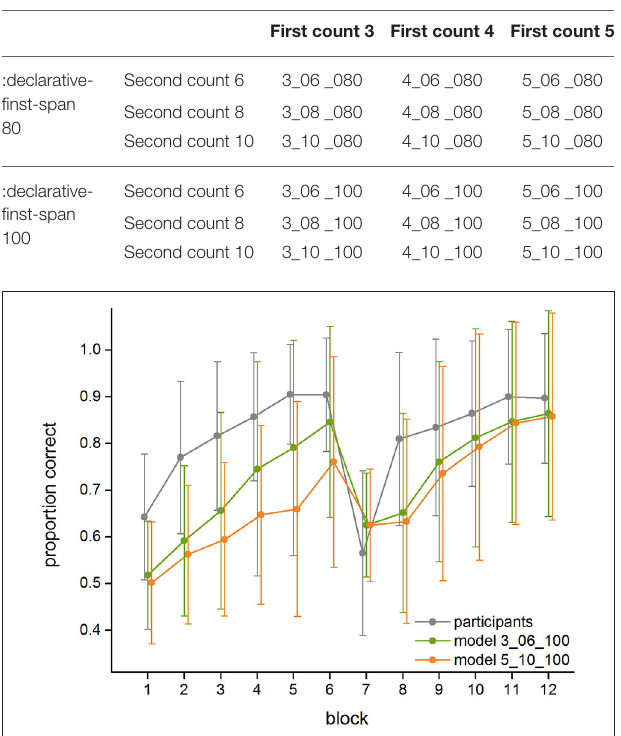
TABLE 1 | Resulting modeling versions from combining the different parameter settings for the first and second count and the declarative-finst-span.